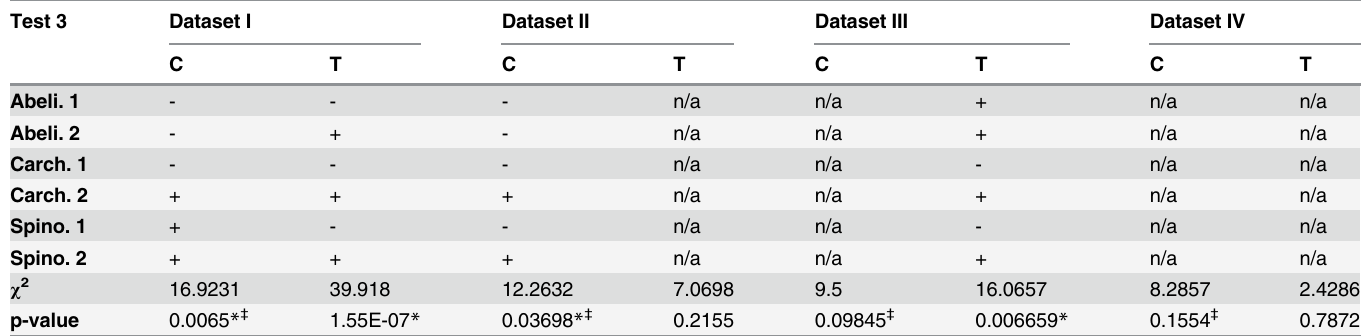
Table 4. Results of Chi-square Test 3 as presented by software